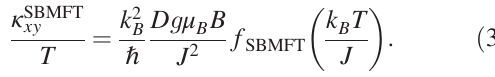
of kagome exp at D=J ¼ SBMFT